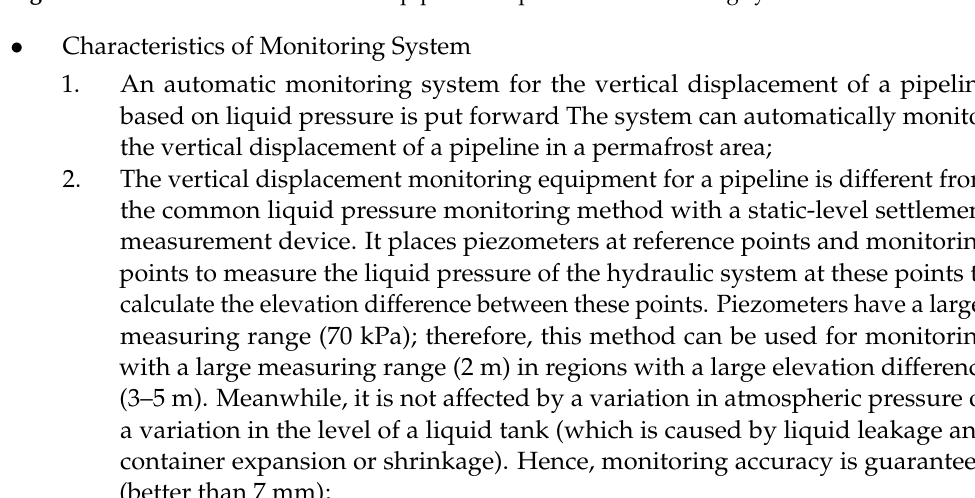
Figure 15. Markers and benchmarks of pipeline-displacement monitoring